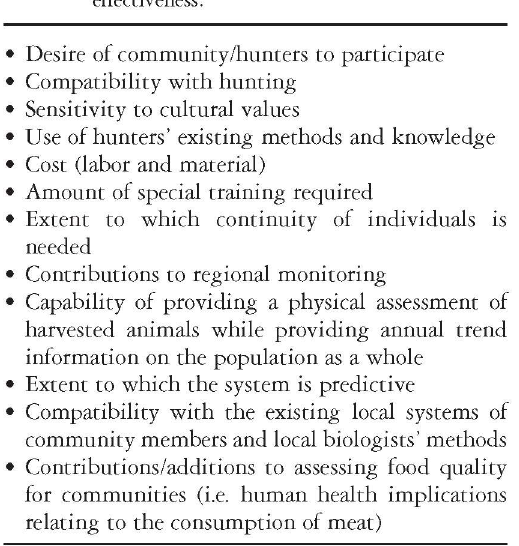
Table 4. Determinants of community monitoring